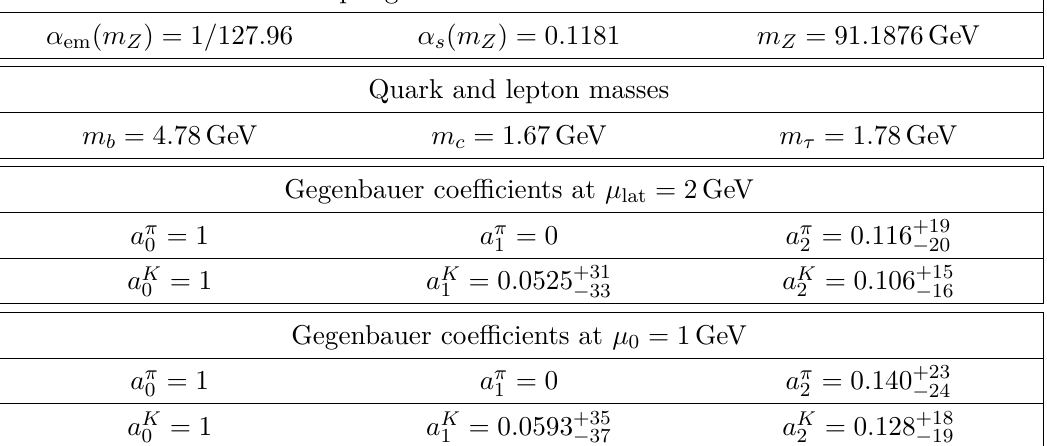
Table 1 . Numerical inputs. The Gegenbauer coefficients at µ lat = 2 GeV are the lattice QCD results from [22]. The quark masses are to be understood as two-loop pole